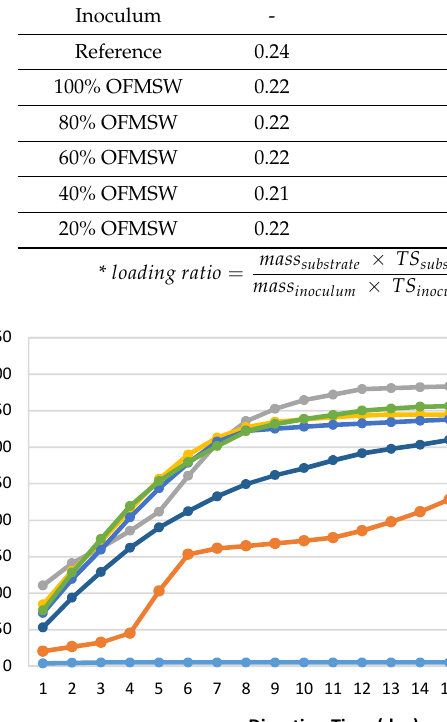
Table 3. Bio-methane production at different mixing ratios.